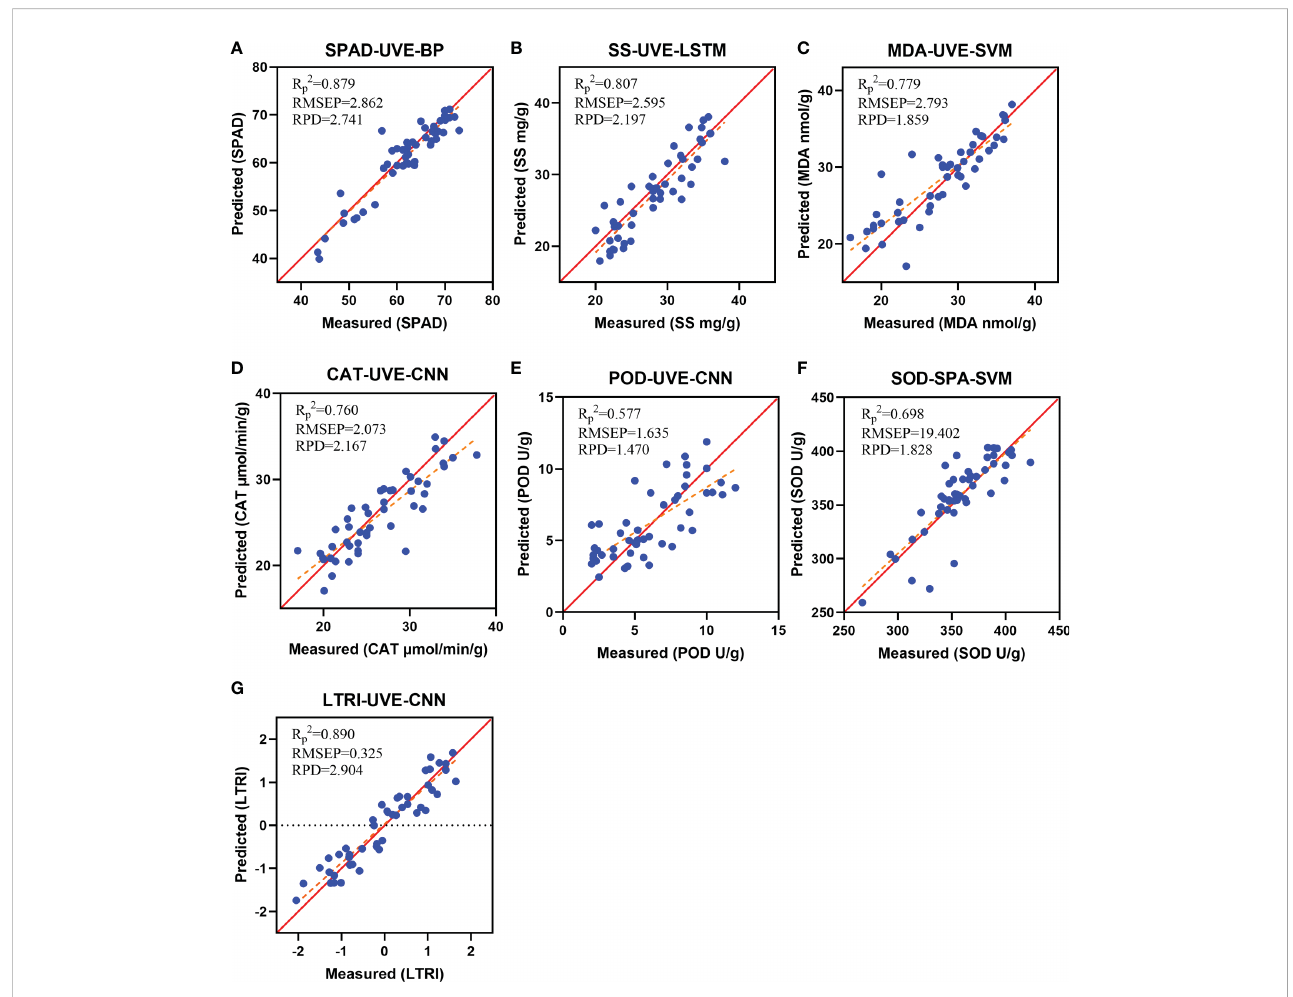
FIGURE 6 Scatter plot of measured and predicted values. (A) SPAD-UVE-BP; (B) SS-UVE-LSTM; (C) MDA-UVE-SVM; (D) CAT-UVE-CNN; (E) POD-UVE-CNN; (F) SOD-SPA-SVM; (G)